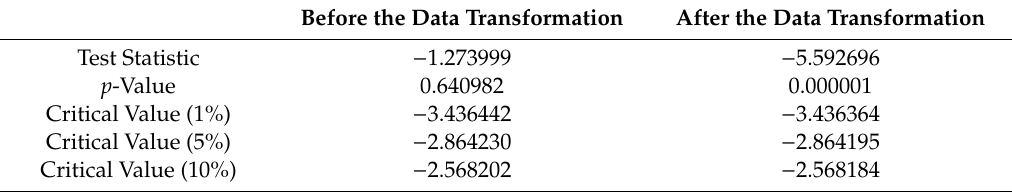
Table 1. Results of augmented Dickey–Fuller (ADF) test before and after the data transformation of NO 2 . Before the Data Transformation After the Data Transformation Test